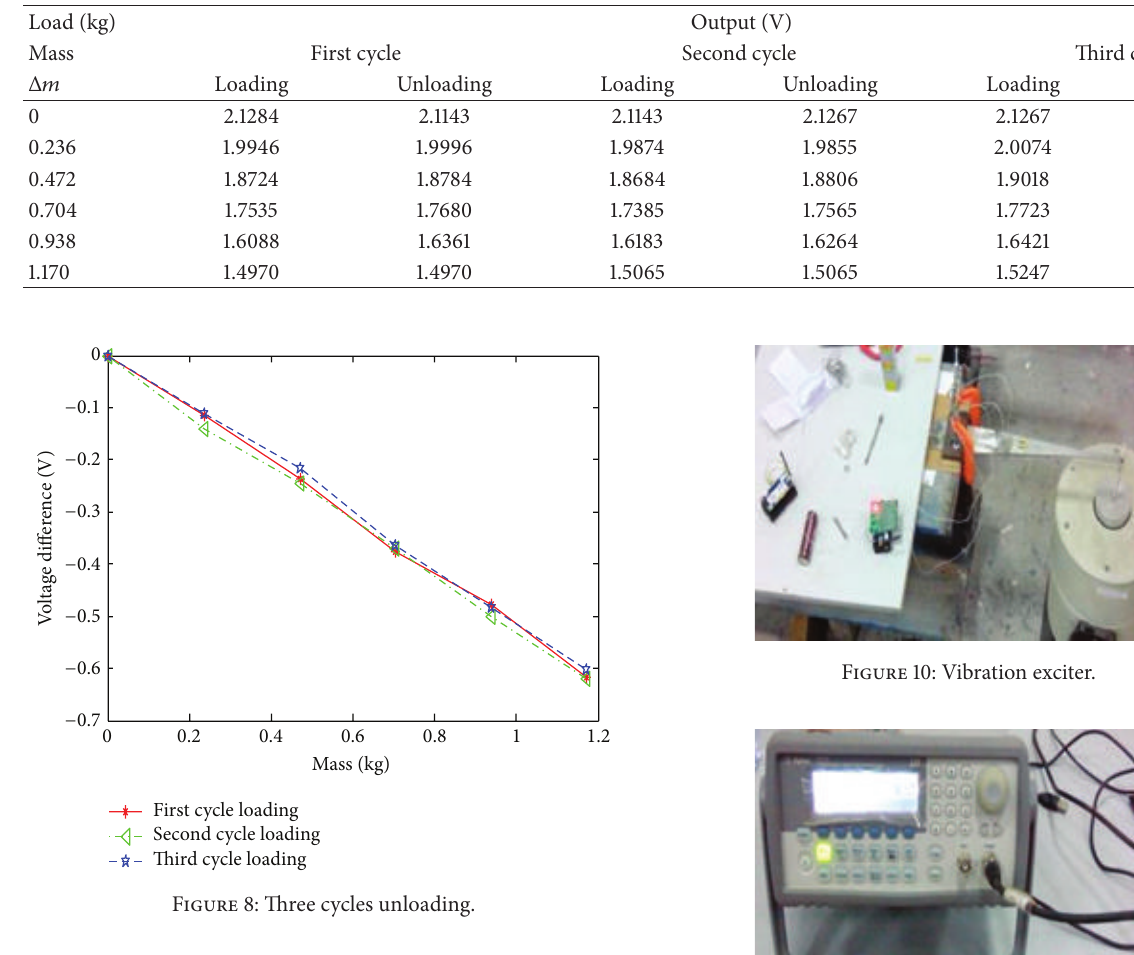
Table 1: Loading and unloading of three cycles.